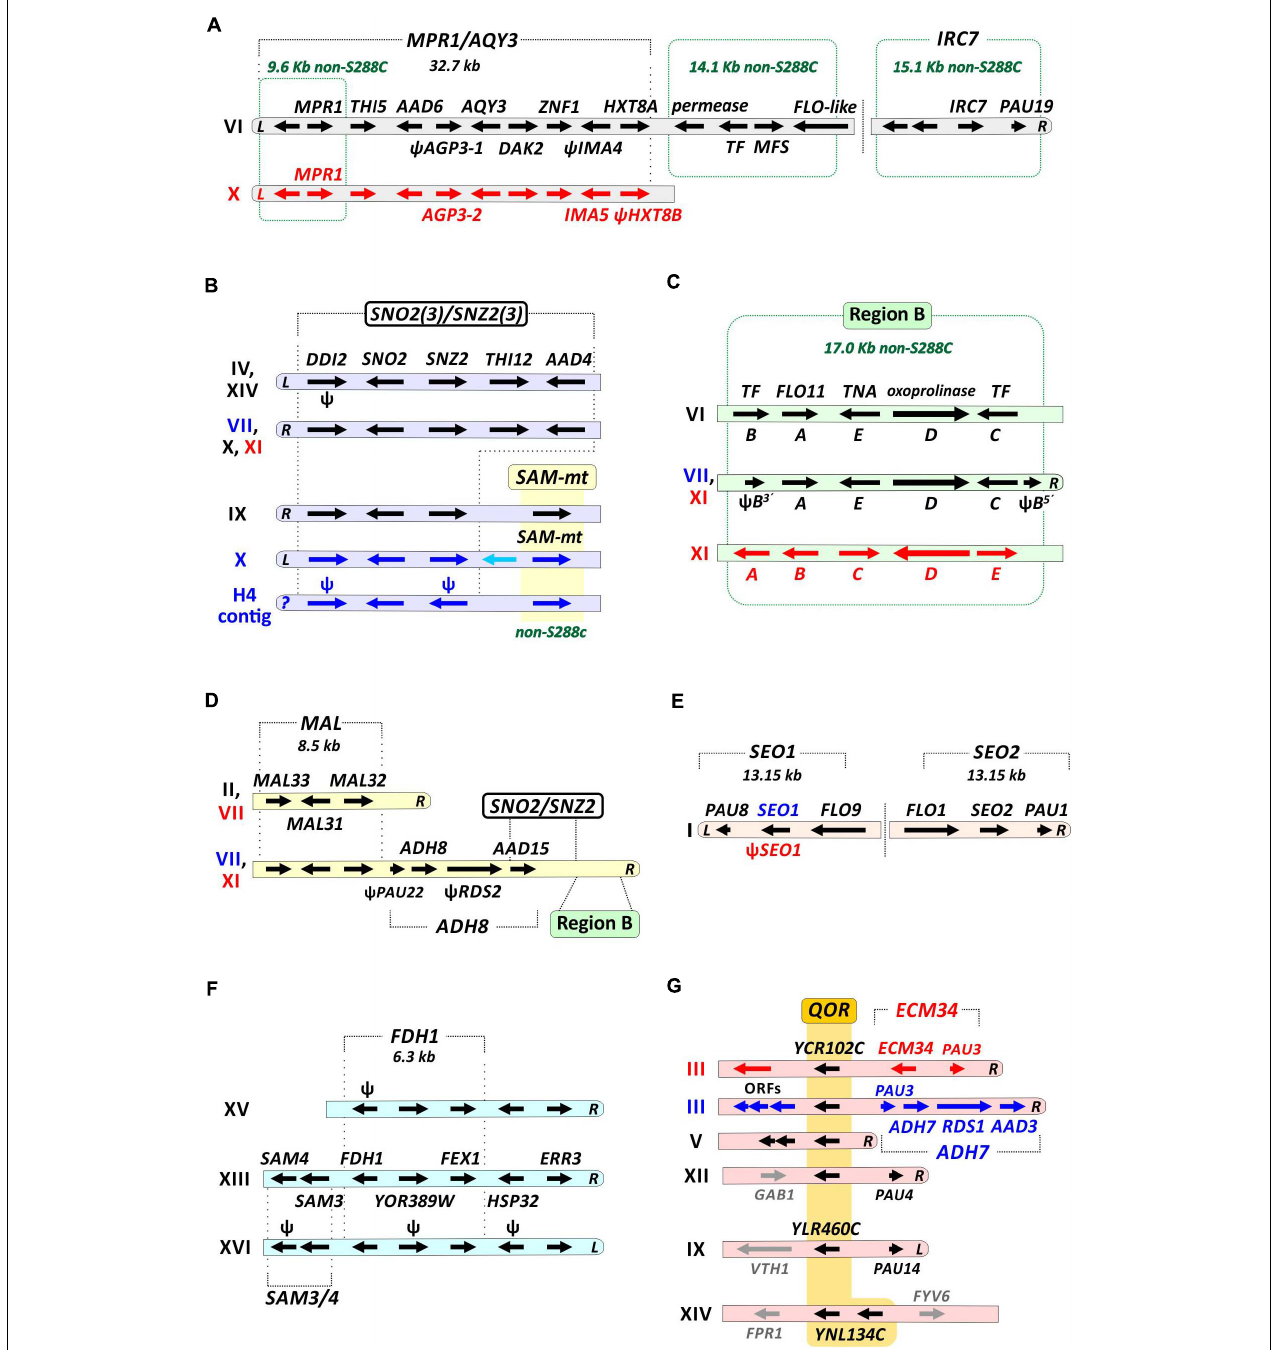
FIGURE 2 | Structural representation of key regions amplified in H3 and H4 genomes. Gene-encoding regions that have increased copy numbers or are not found in S288C are shown. Structural dimensions of genes (arrows) and their chromosomal dispositions are schematic (i.e., not in scale). Chromosome numbers are shown on the left. Rounded chromosome tips indicate that the depicted region has a subtelomeric location at either the left ( L ) or right ( R ) arm of the chromosome; their absence indicates that the respective gene region lays at the chromosome core. Genes and their respective labels that are indicated in black represent alleles found in both H3 and H4. Red represents alleles found only in H3, and those in blue exclusively in H4. Putative pseudogenes ( ψ ) are also indicated. Non-S288C regions are framed by green dashed lines forming a rectangle. (A) The MPR1 / AQY3 region encompasses 10 genes within c. 32.7 kb. It is placed at the left subtelomere of Chr. VI (in H3 and H4) and on the Chr. X (only in H3). A 14.1 kb non-S288C segment encoding a permease, a transcription factor (TF), a transporter of the major facilitator superfamily (MFS), and a FLO-like protein is located downstream of the MPR1 / AQY3 region. The IRC7 region is at a distal position at the subtelomeric part of the Chr. VI right arm. (B) The SNO2(3) / SNZ2(3) cluster is a multi-copy region in the H3 and H4 genomes. On the Chr. IX and X of H4, SNO2(3) / SNZ2(3) is flanked by genes encoding SAM-dependent methyltransferases ( SAM-mt , yellow), a non-S288C gene family ubiquitous in fuel ethanol strains. The same configuration is